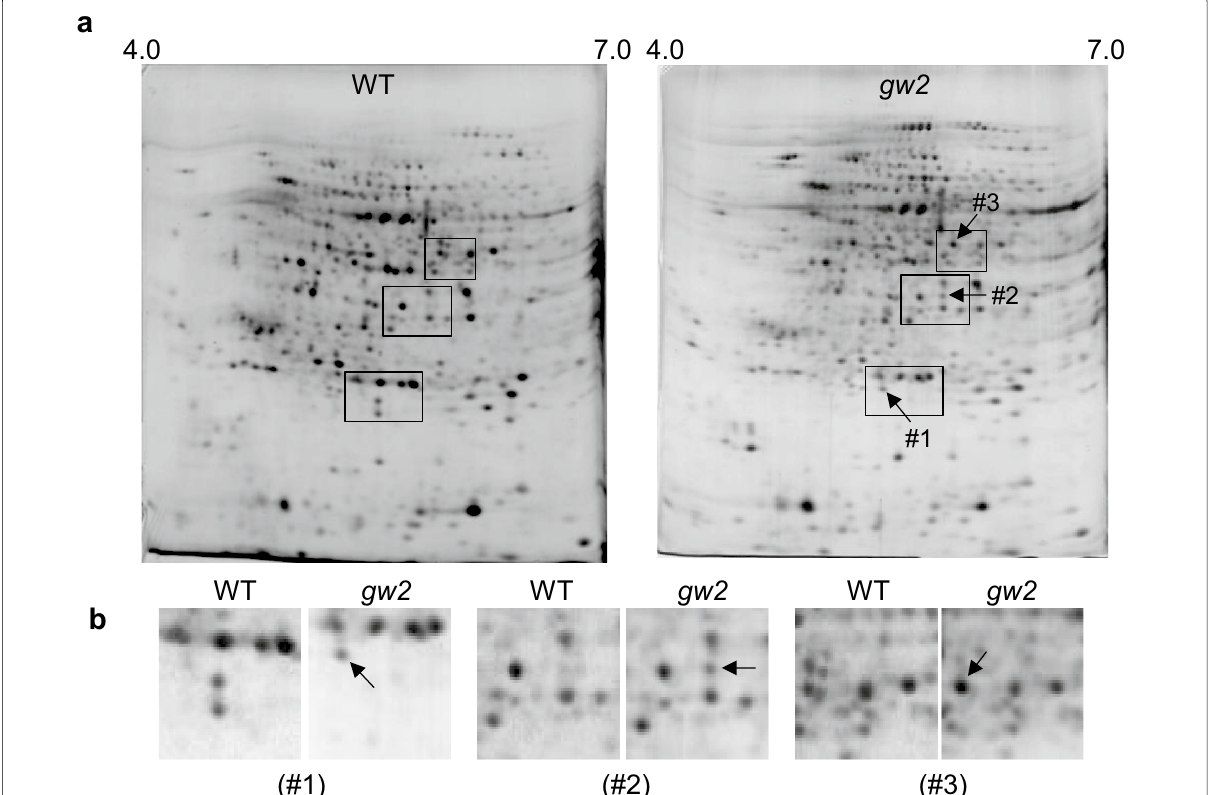
Fig. 1 Proteomic analysis of seed proteins in the grain width 2 ( gw2 ) mutant of rice, Oochikara. Total proteins were extracted from whole seeds and subjected to isoelectric focusing (IEF) in the first dimension, using immobilized pH gradient dry strips (pH 4–7 nonlinear, 24 cm in length), and SDS-PAGE in the second dimension, using 10–16% gradient polyacrylamide gels. Gels were stained with silver nitrate. Three independent biological replicates were performed. a 2D gels showing protein spots in wild-type and gw2 mutant rice. Arrowheads indicate highly accumulated proteins in the gw2 mutant compared with the wild type. Boxed regions shown in a are magnified in b . Spot #1, glyceraldehyde 3-phosphate dehydrogenase (GAPDH); spot #2, chitinase 14 (CHT14); spot #3, phosphoglycerate kinase